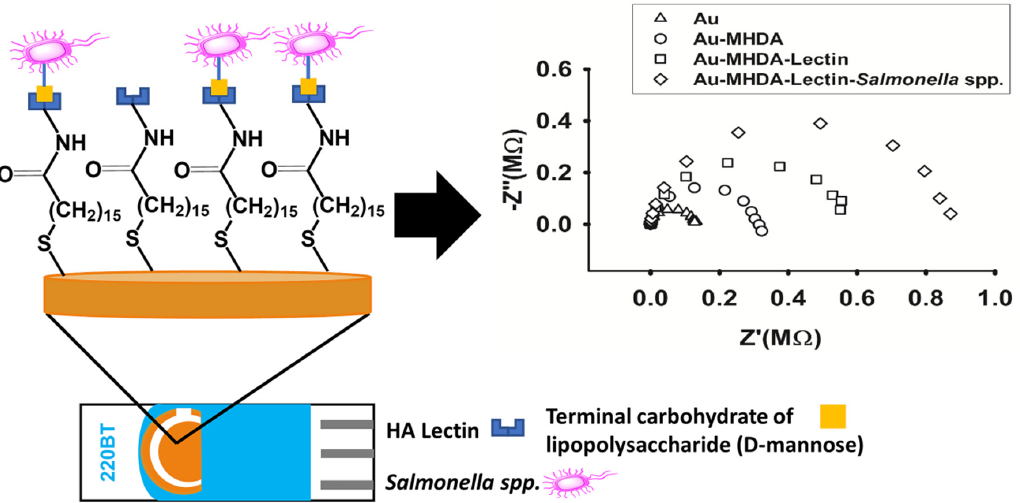
Figure 5. Recognition scheme for Salmonella spp. with the biosensor.